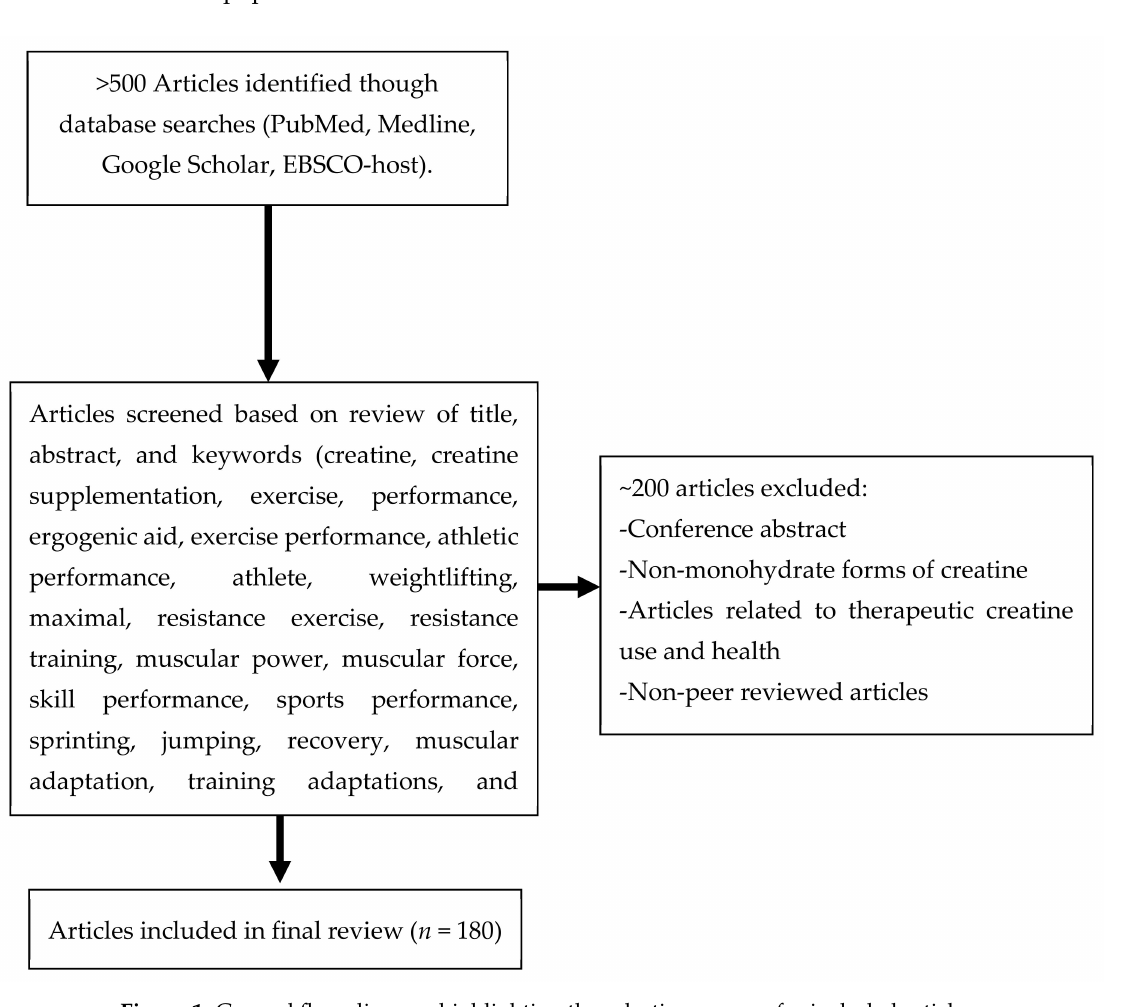
Figure 1. General flow diagram highlighting the selection process for included